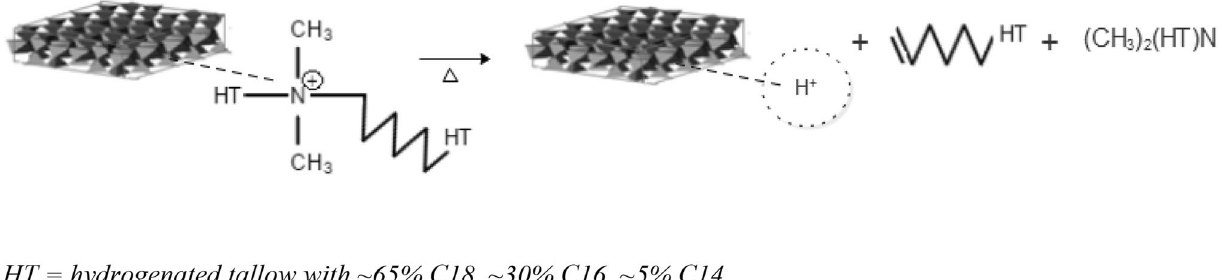
Fig. 5 The Hoffman elimination reaction for quaternary ammonium compounds in